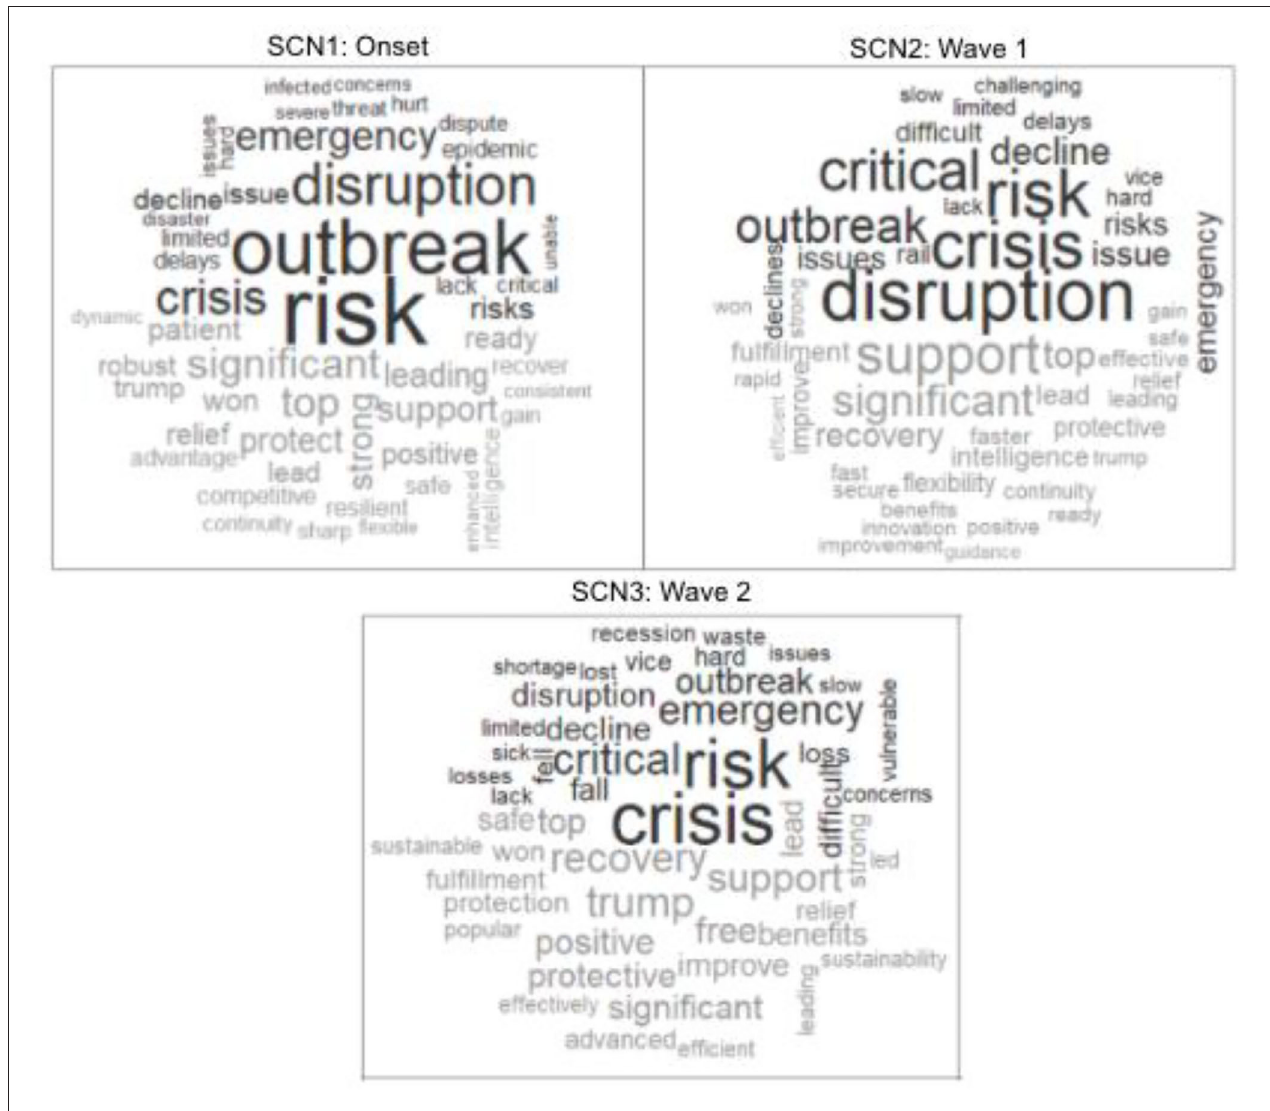
FIGURE 7 | Word cloud with sentiment